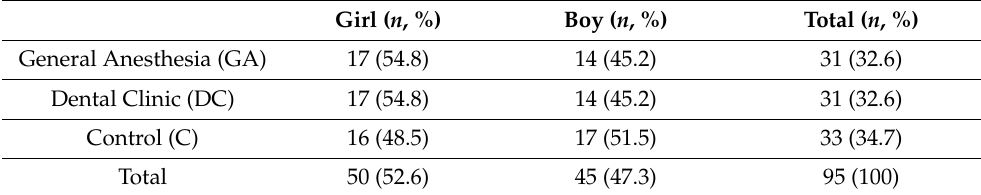
Table 1. Distribution of gender by the groups.